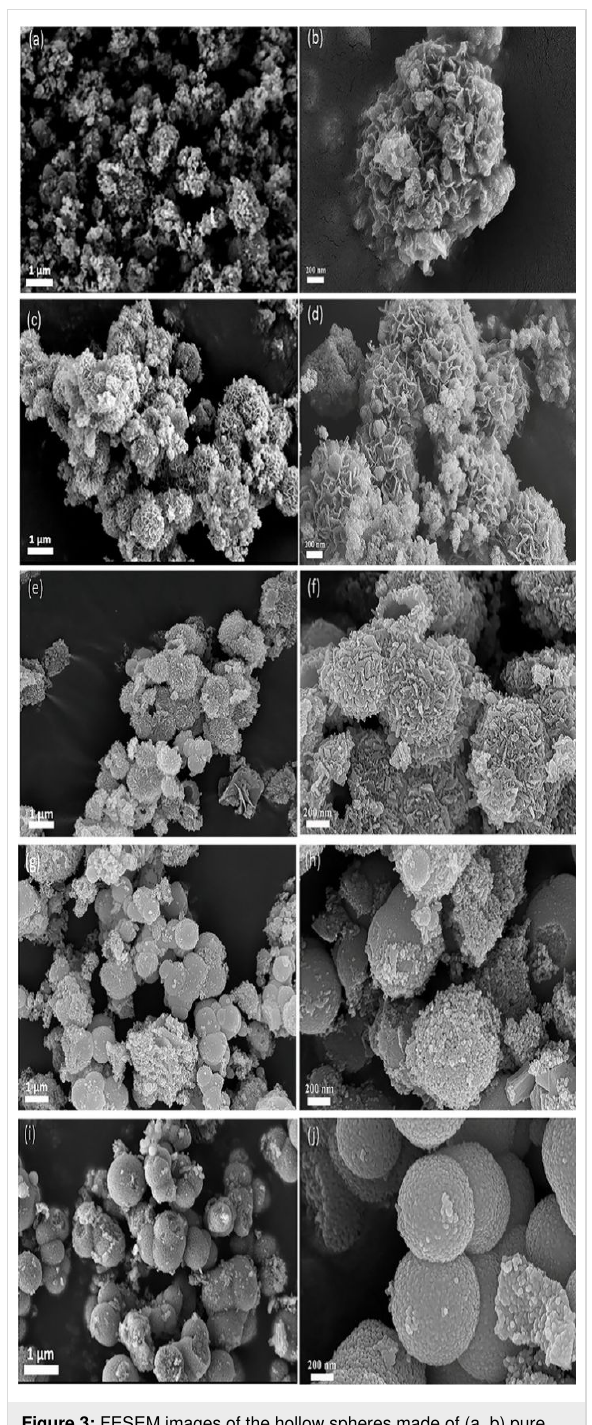
Figure 3: FESEM images of the hollow spheres made of (a, b) pure ZnFe 2 O 4 and composite ZnFe 2 O 4 /rGO with an rGO percentage of (c, d) 0.1, (e, f) 0.25, (g, h) 0.5 and (i, j) 1 wt %.